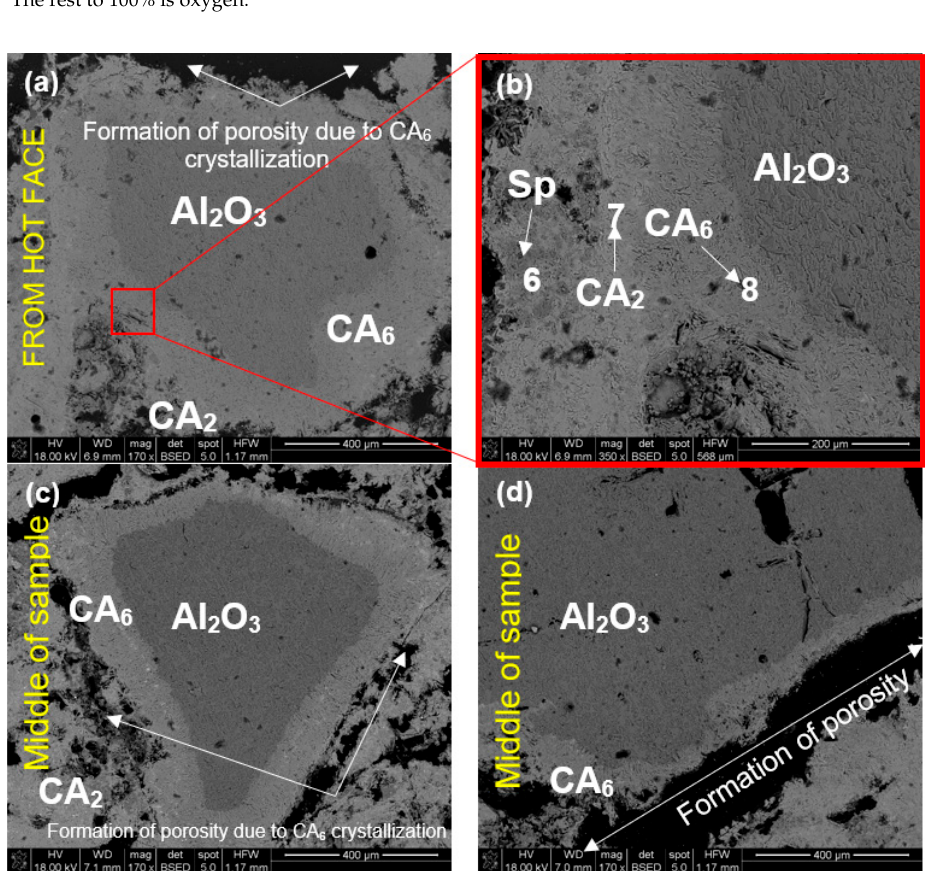
Figure 13. SEM images of sample Al-1-2 corroded by R slag (1450 ◦ C, 10 h); ( a ) hot-face zone, ( b ) higher magnification of hot-face zone, ( c , d ) middle of the sample (core